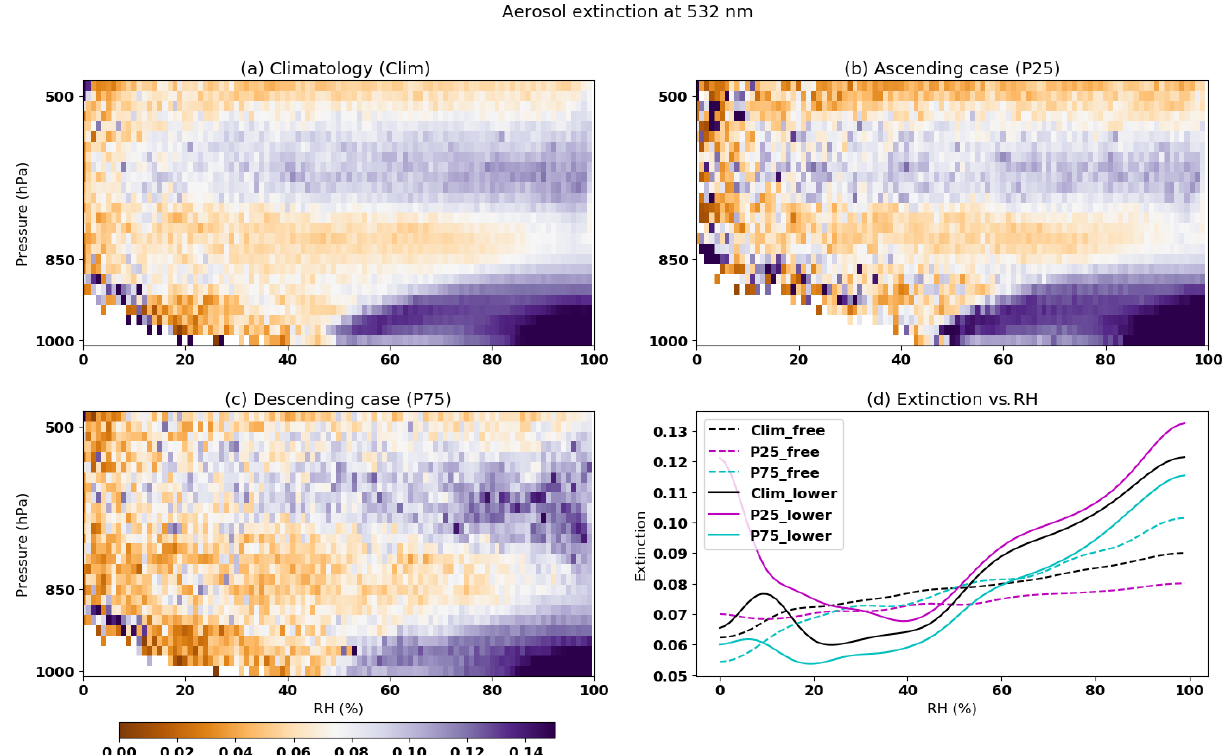
Figure 7. The same as in Fig. 6 but for the extinction coefficient